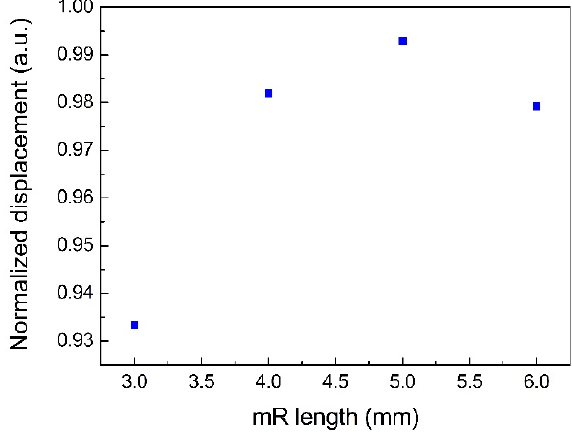
Figure 6 . Calculated normalized displacement as a function of mR length.